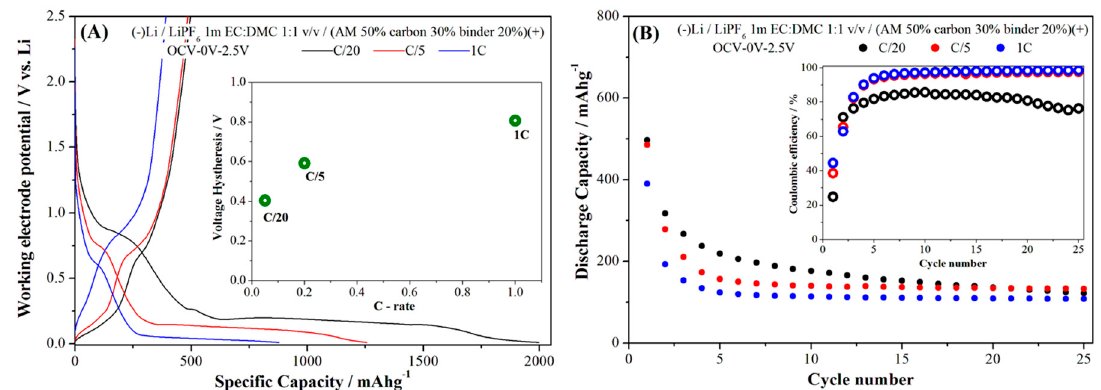
Figure 6. ( A ) Voltage profile of Mg 2 FeH 6 (RBM sample after H 2 sorption at 485 °C) obtained upon discharge and following re-charge in a lithium cell (in the (a-inset) the voltage hysteresis vs. the C-rate is shown) ( B ) specific capacity measured upon cycling at various current rates (RBM sample after H 2 sorption at 485 °C); in the (b-inset) the trend of the coulombic efficiencies are shown).